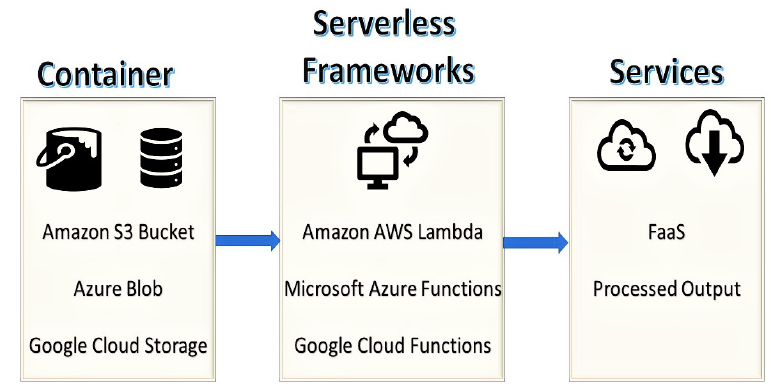
Figure 4. Generalized architecture for existing serverless computing